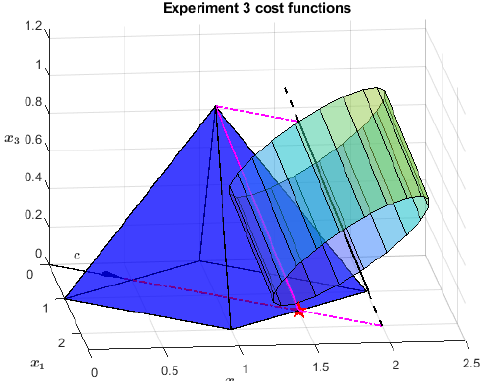
Figure 6. Cost functions: the primary is the distance from the oblique line, each infinite cylinder is a level surface; the secondary maximizes the sum of x 1 and x 2